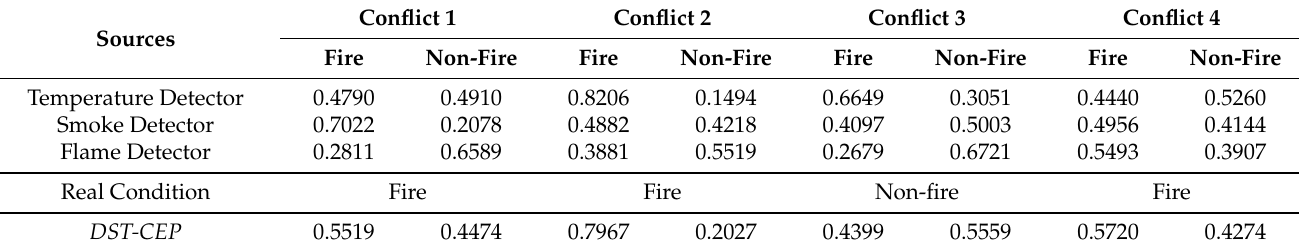
Table 1. Results of conflicting hypotheses and DST-CEP